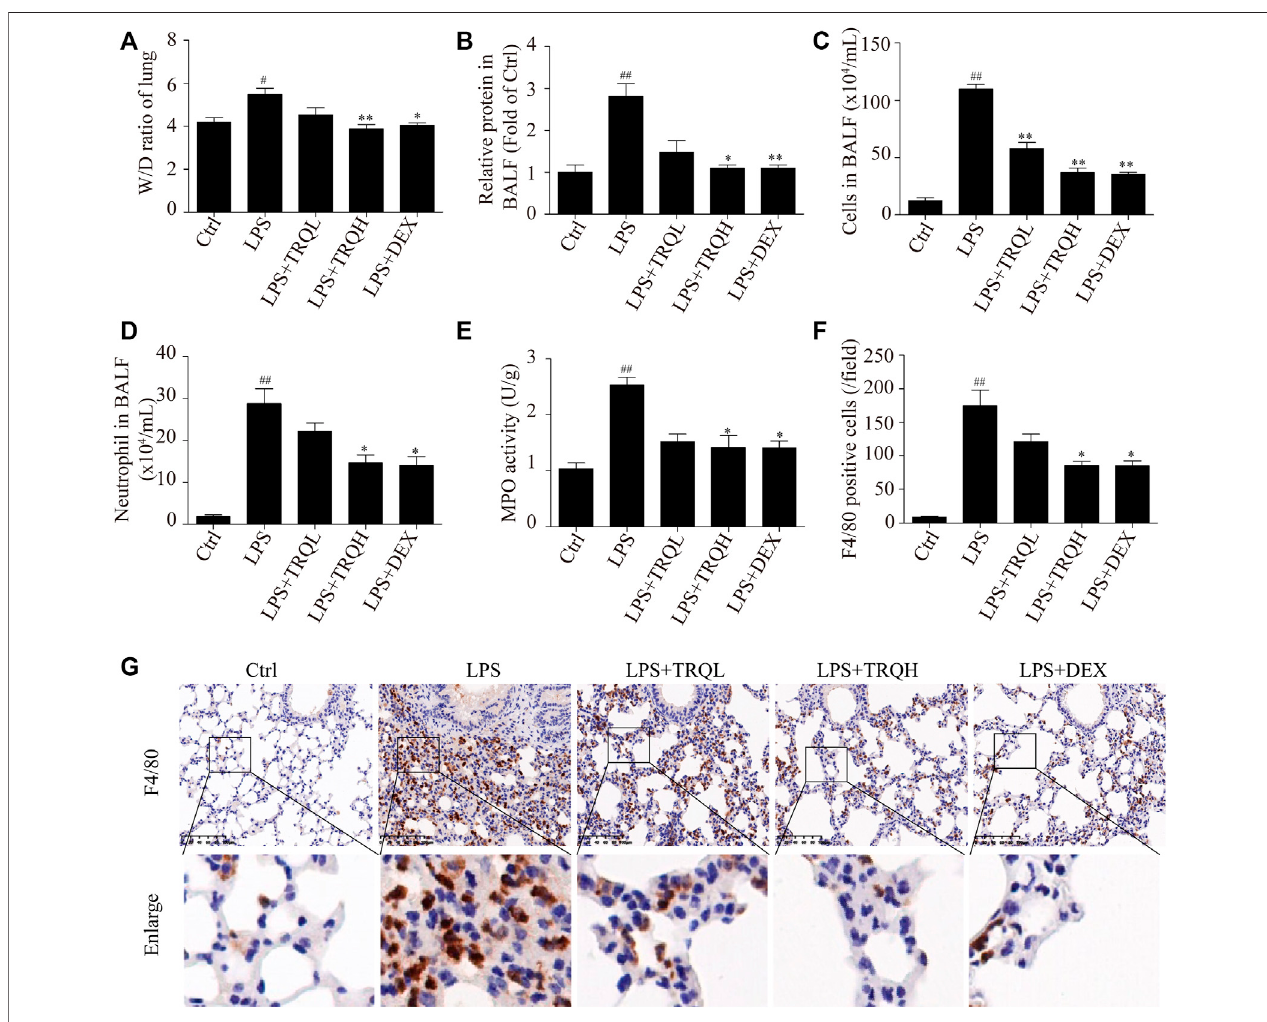
FIGURE3| TRQ alleviated lungedema and in fl ammatorycellsin fi ltration inLPS-induced ALImice. (A) LungW/D ratio. (B) Total protein concentrationin BALF. (C) Total cell number in the BALF. (D) The number of neutrophils in BALF. (E) MPO activity in lung injury. (F – G) Representative images and quantitative analysis of macrophages stainedwiththemacrophagemarkerproteinF4/80. n (cid:2) 5 – 6. # p < 0.05and ## p < 0.01vs.Ctrlgroup; *p < 0.05and ** p < 0.01vs.LPSgroup, respectively.